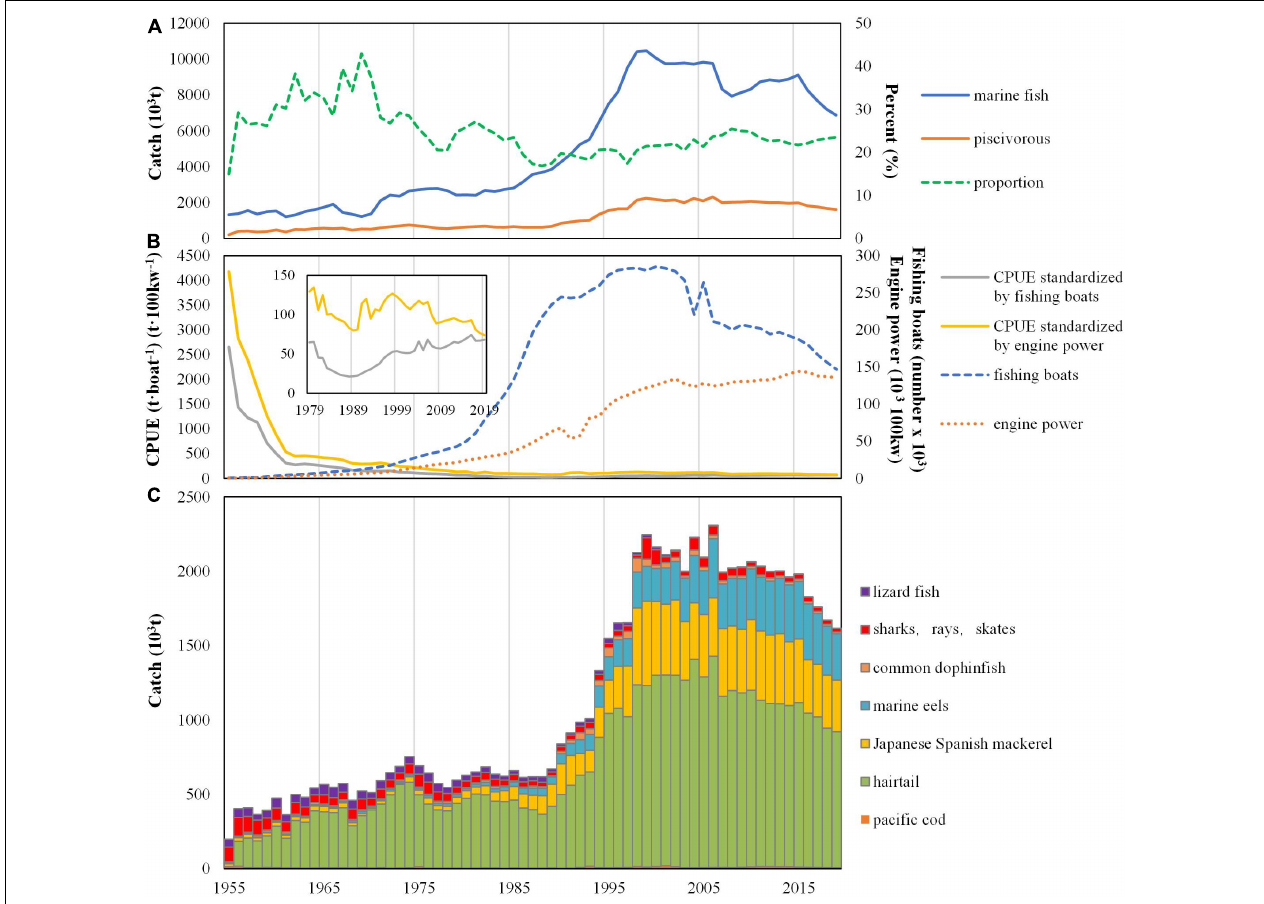
FIGURE 2 | Annual variations in catch of marine fish and piscivorous fish in China for the period of 1955–2016. (A) Trends in catch of marine fish and piscivorous fish as well as proportion of piscivorous fish catch in the total catch of marine fish. (B) Marine fishing boats and their engine power, and CPUE of marine fishes by fishing boats and engine power, respectively. (C) Catch of piscivorous